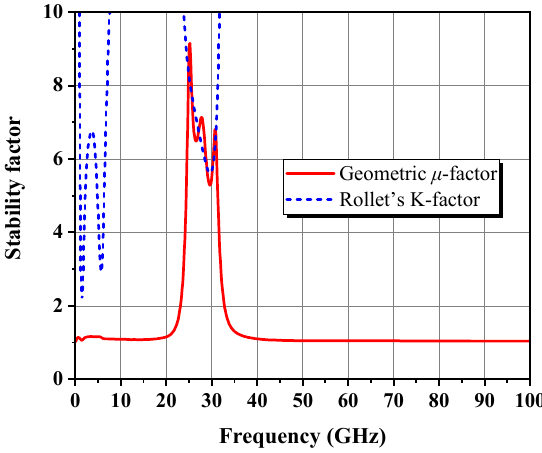
Figure 20. Stability factors of the final DA.